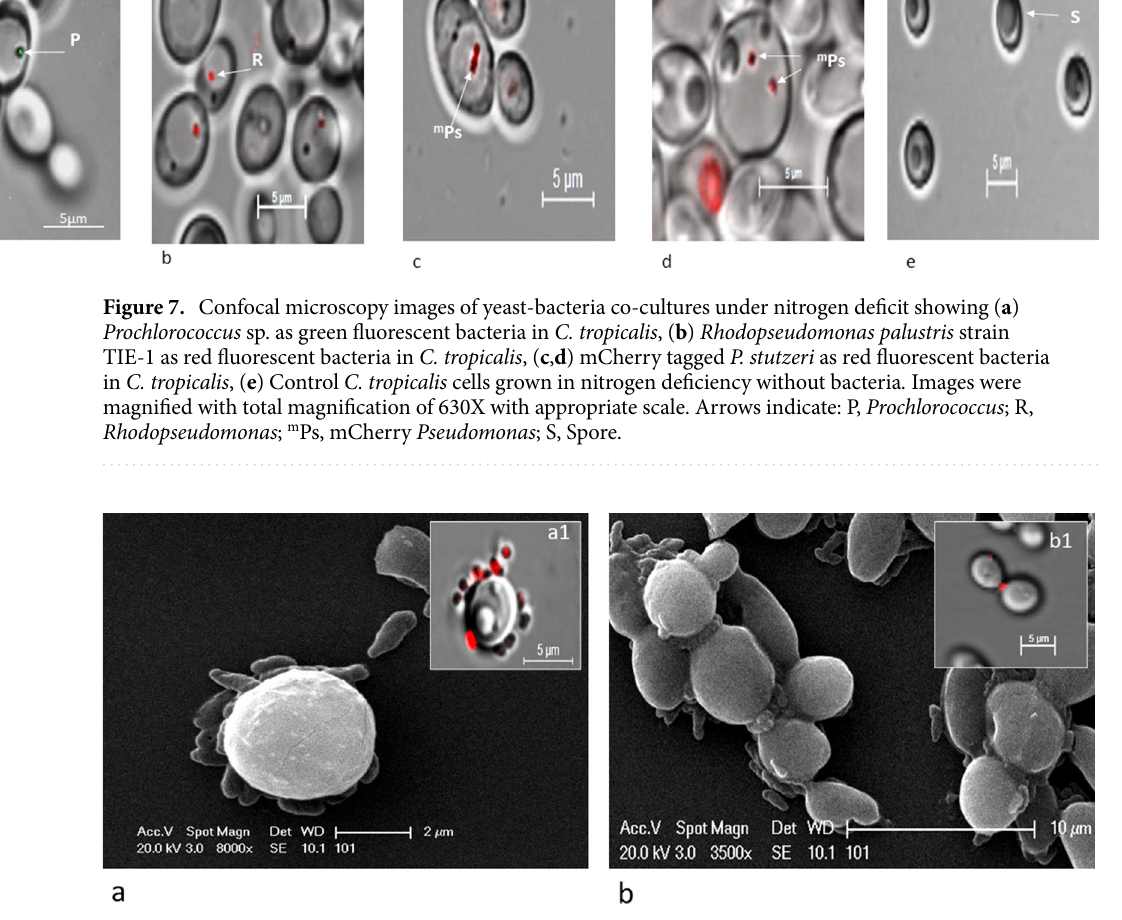
Figure 8. Scanning electron microscopy (SEM) images showing ( a ) P. stutzeri bacteria attachments on a C. tropicalis cells, ( b ) P. stutzeri attachments onto C. tropicalis bud collars. Insert: (a1) Confocal microscope image showing similar P. stutzeri attachment on a C. tropicalis cell, (b1) Confocal microscope image showing similar P. stutzeri attachment onto budding C. tropicalis